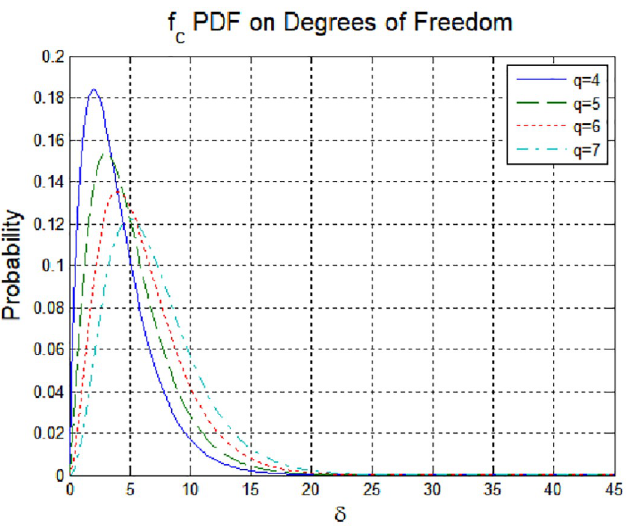
Fig 3. Probability density function according to the degrees of freedom.